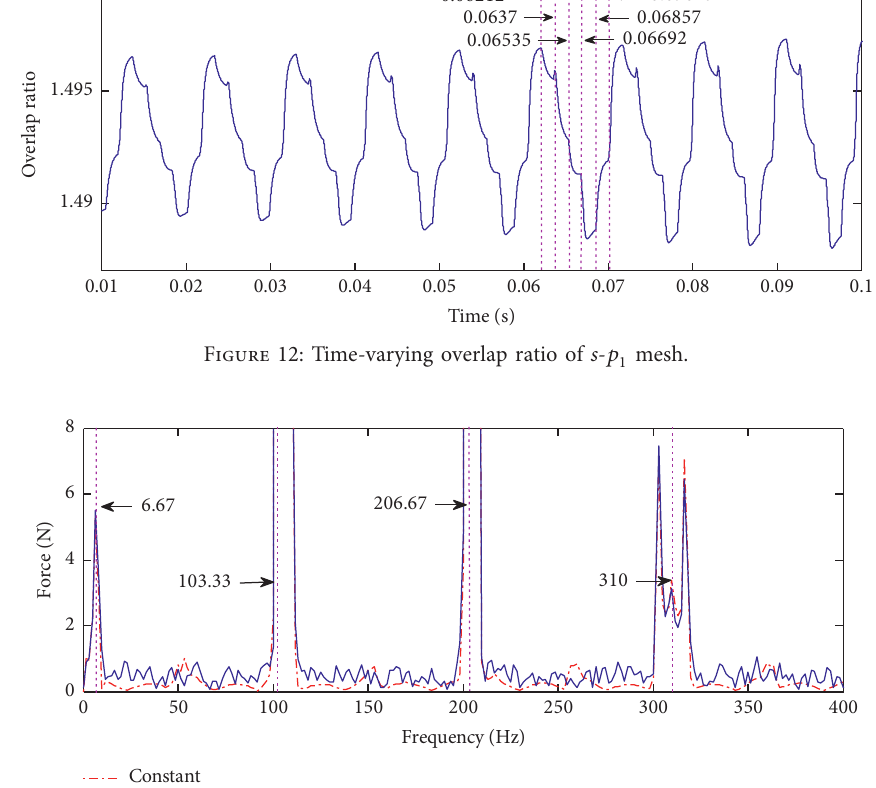
mesh in constant and time-varying pressure angle and overlap 1